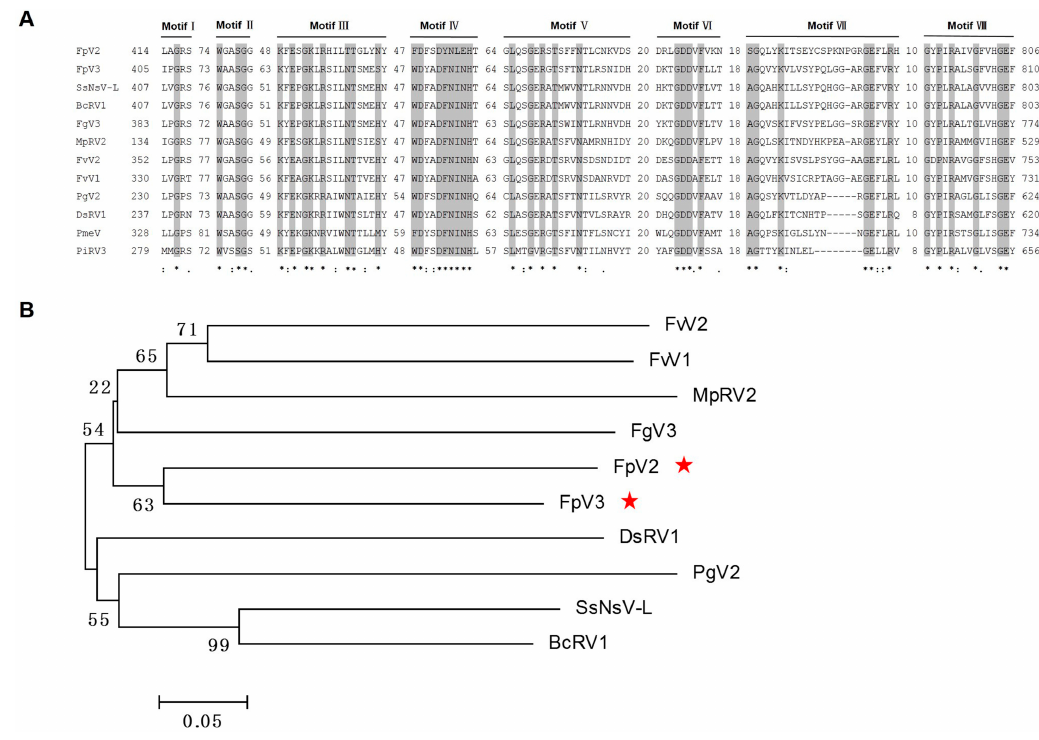
Figure 5. ( A ) Multiple alignments of the homologs of Phytoreo_S7 domain from FpV2, FpV3, and related viruses. Asterisks, colons, and dots represent identical amino acid residues (shaded gray), conserved amino acid residues, and semi-conserved amino acid residues, respectively; ( B ) Phylogenetic tree of the Phytoreo_S7 domain homologs from FpV2, FpV3 (marked by stars) and eight related RNA viruses. The phylogenetic tree was generated by NJ method (1000 bootstrap replicates) in MEGA 6.0. See legend to Figure 4 for abbreviations of the virus